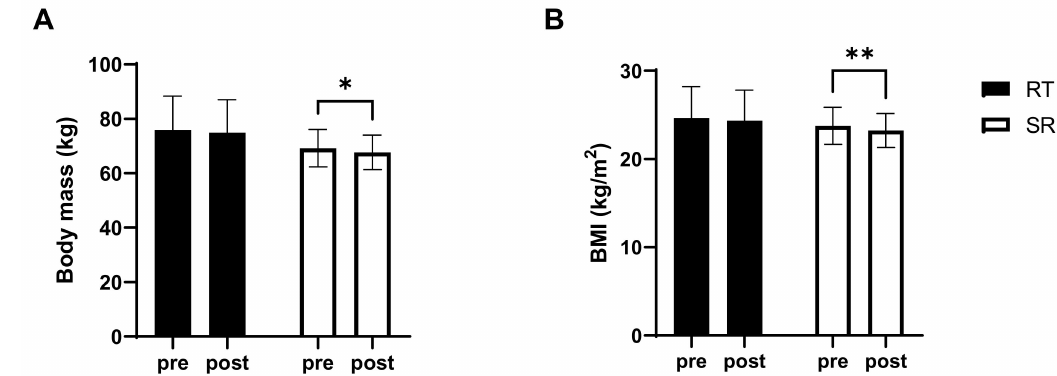
Figure 1. ( A ) body mass and ( B ) body mass index (BMI). RT resistance training group; SR, spot reduction group. * signifi- cantly different from pre-value ( p < 0.05); ** significantly different from pre-value ( p <